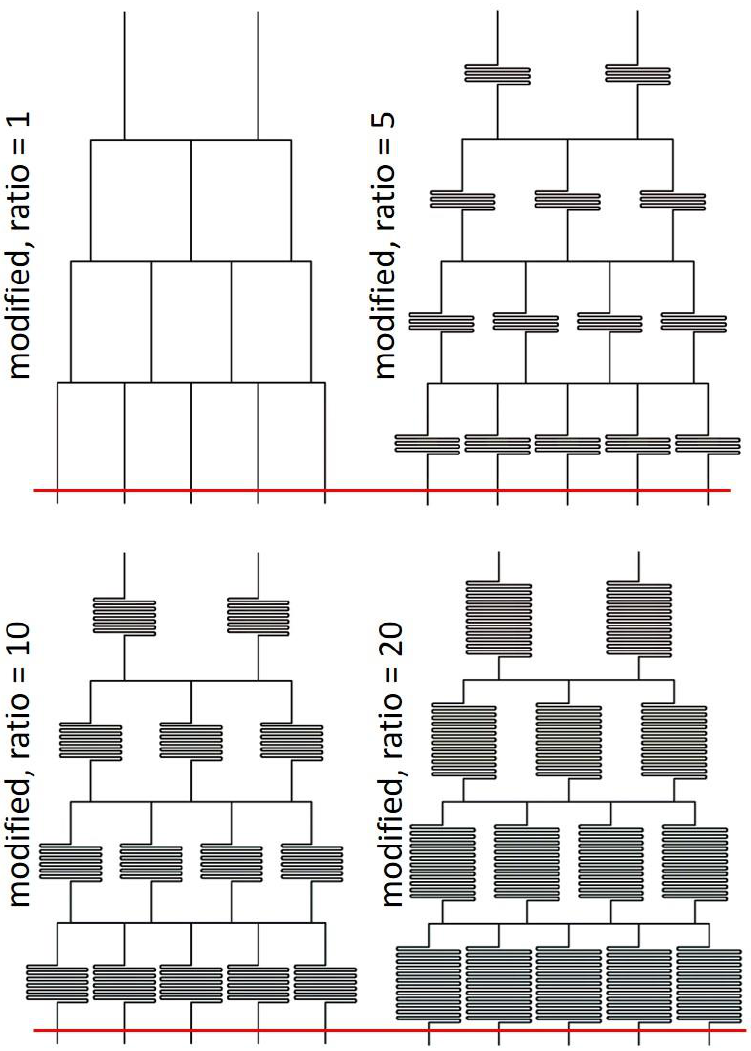
Figure 6. Designs of modified microfluidic chips with four different ratios of R V / R H .